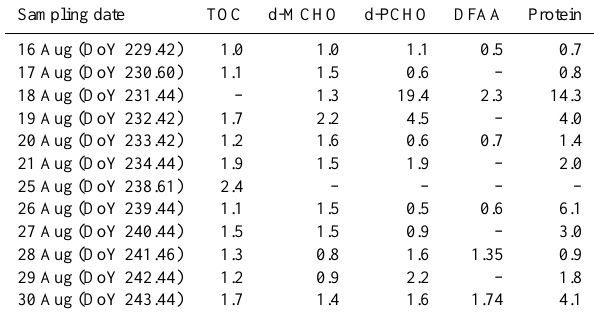
Table 3. Enrichment factor of TOC, d-MCHO, d-PCHO, DFAA and particulate protein in the surface microlayer.